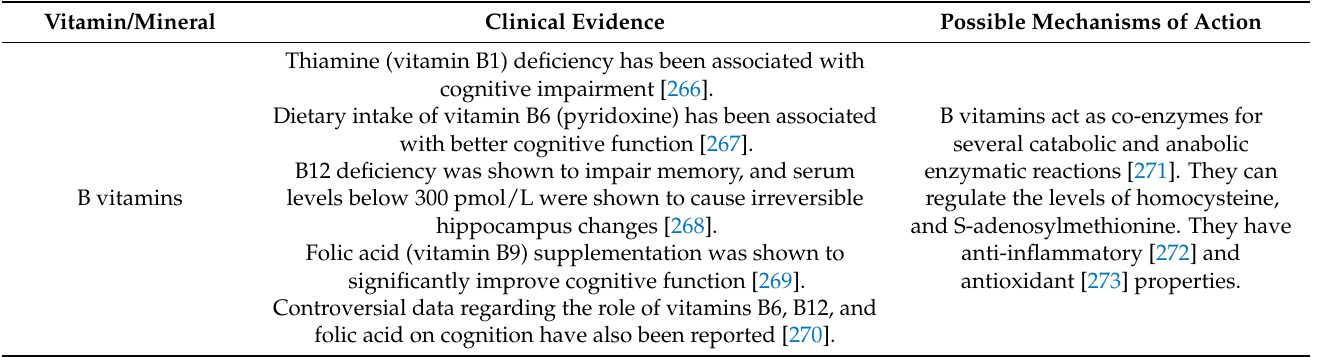
Table 1. The role of micronutrients on cognition and their potential mechanisms of action.